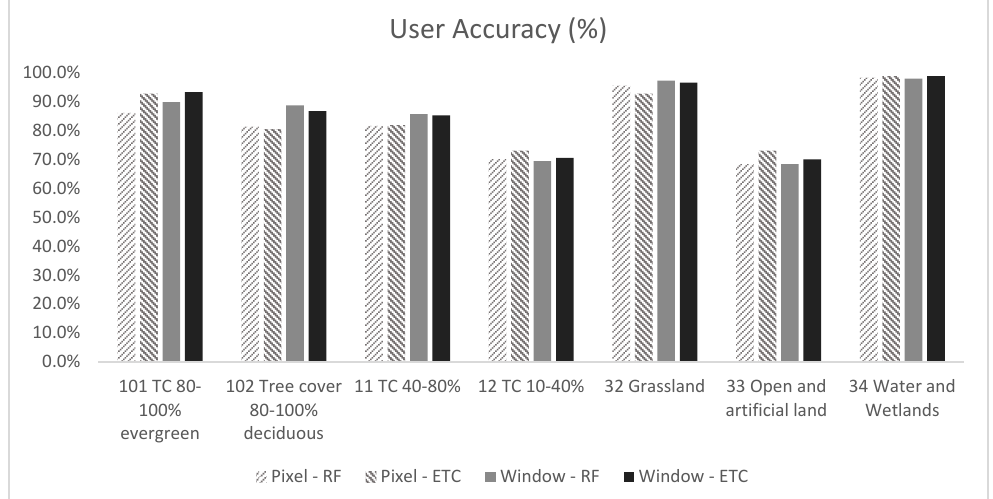
Figure 11. Overall accuracy, producer accuracy and user accuracy of the six maps based on the area proportion. The second part of the accuracy assessment evaluated the discrimination of single trees within the 98 samples that were labelled class 21 (Figure 12). We saw that the differ ‐ ent models captured any type of tree cover class (including class 21) in about half of the samples that were identified as class 21 (Figure 13). The window classification model out ‐ performed the other models, as it gave a more accurate representation of the tree cover percentage in those samples that were labelled as having a 1–10% tree cover. However, the analysis highlights that the discrimination of single trees is still a challenge when using satellite imagery at a 10 m spatial resolution.